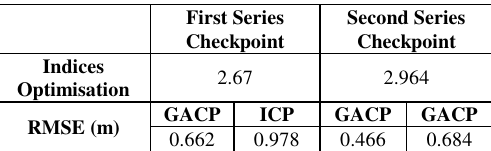
Table 7: Results from IDW Optimisation